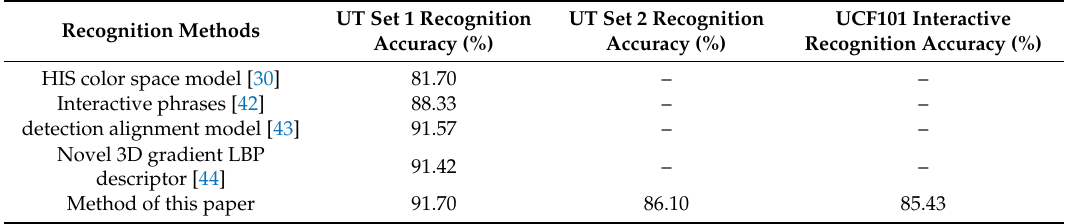
Table 3. Comparison of the recognition accuracy of di ff erent identification